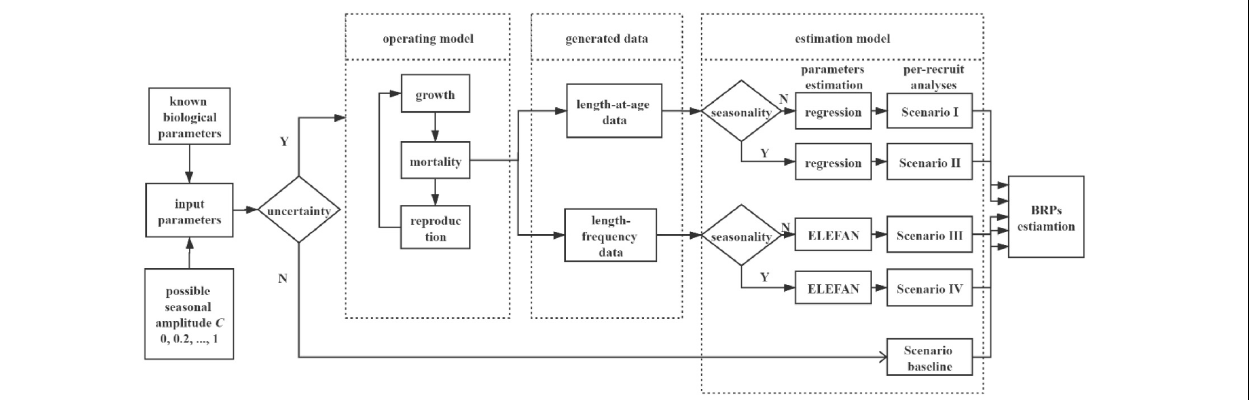
FIGURE 1 | Flowchart of the simulation in the present study. Six gradients of variable C (amplitude of the seasonal oscillation, 0, 0.2, 0.4, ... , 1) are set in this study. Deterministic section (scenario baseline) runs 1 time for each gradient of C , as the output is a deterministic value without uncertainty. Stochastic simulation runs 1000 times for each gradient of variable C , incorporating with individual growth variations (variability of K and L ∞